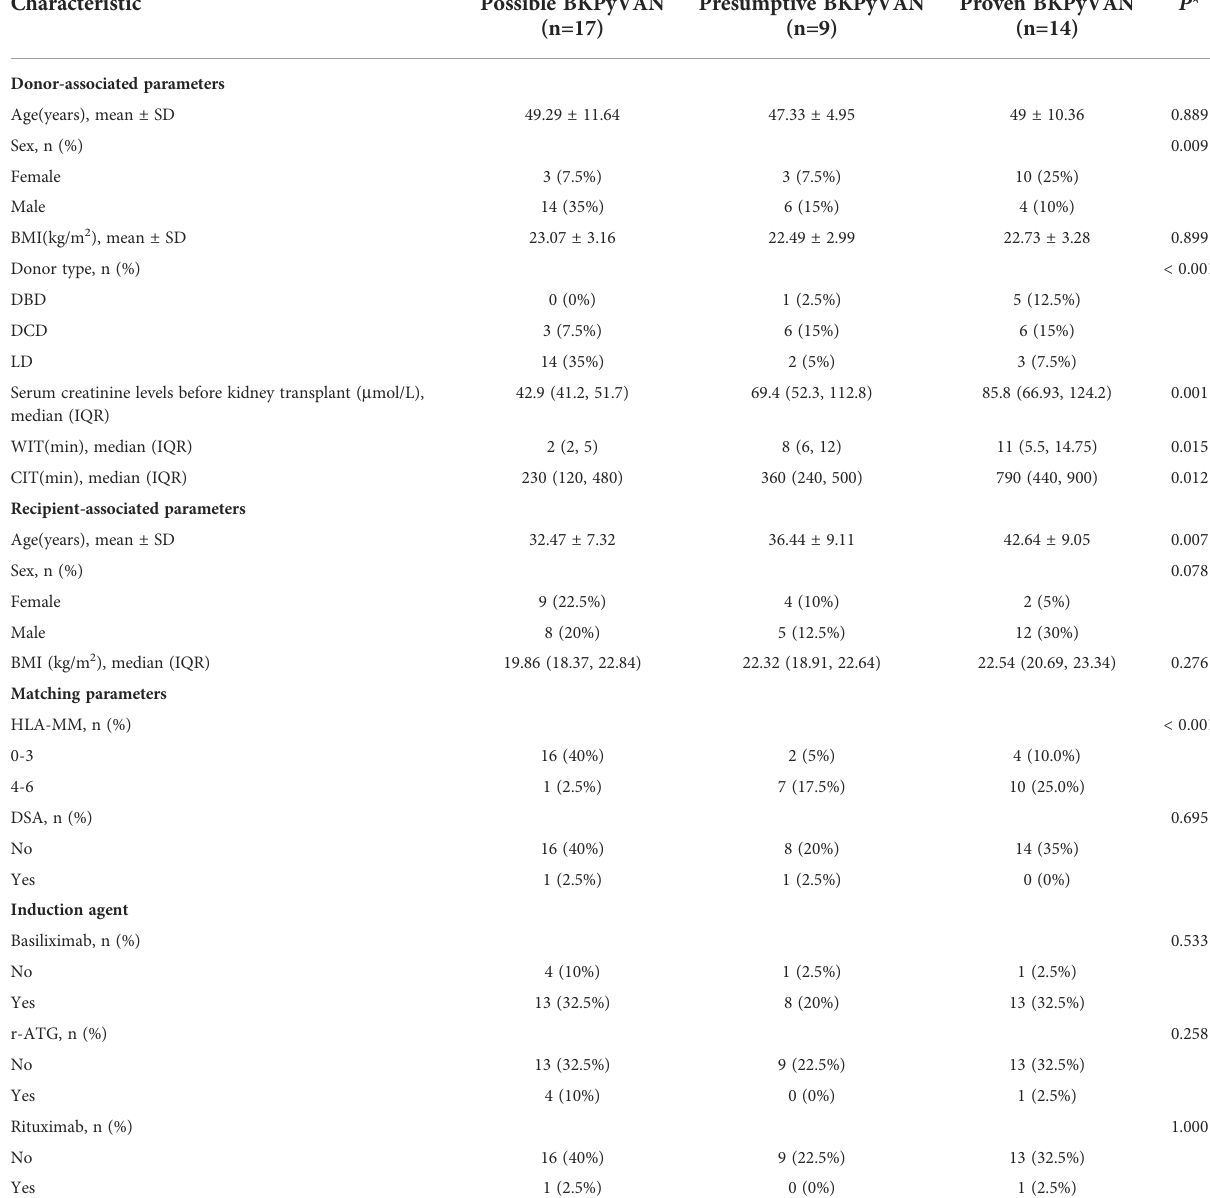
TABLE 3 Characteristic of possible BKPyVAN, presumptive BKPyVAN, and proven BKPyVAN patients.